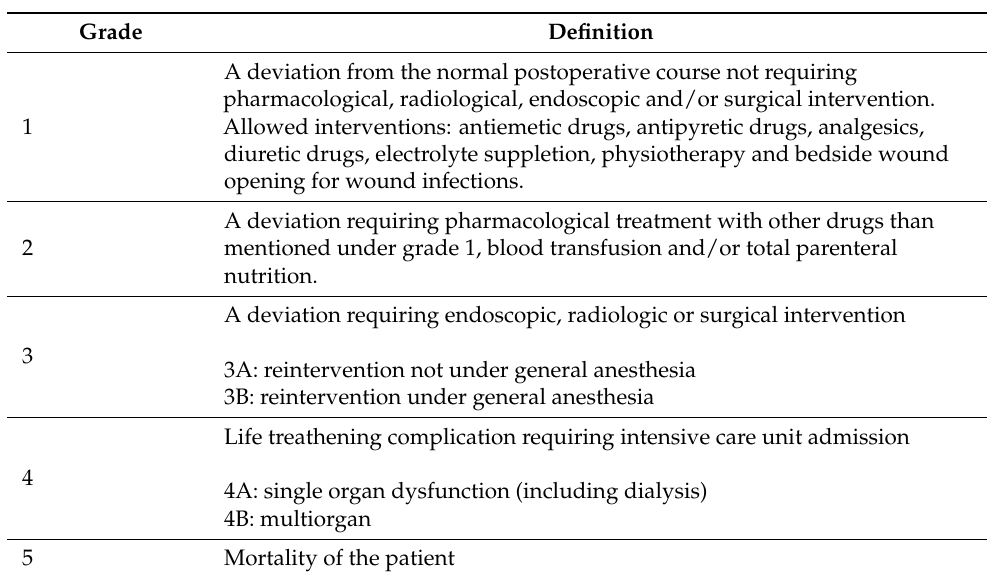
Table 3. Clavien–Dindo complication grading system